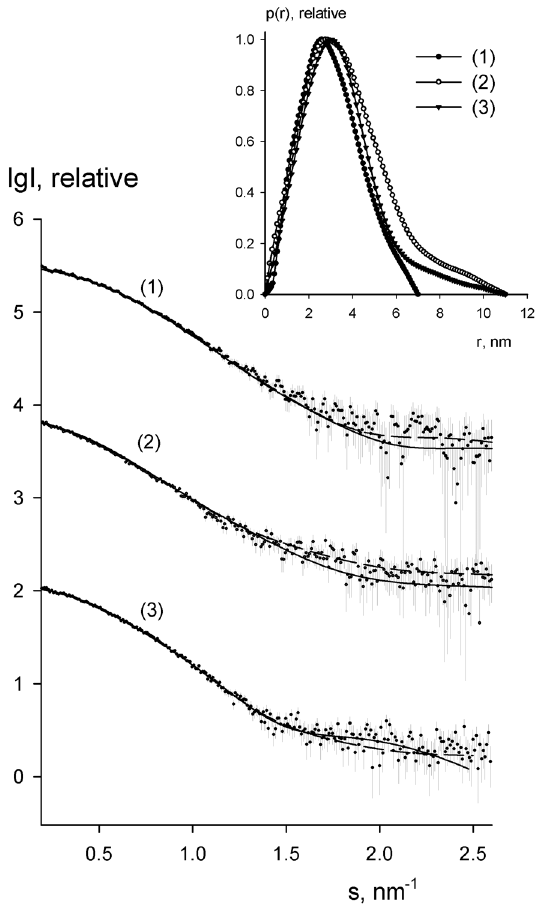
Figure 1. The experimental X-ray scattering data and the obtained fits. Curves 1–3 correspond to M.NlaX, M.SsoII and M.SsoII– 15met complex,respectively. Experimental data are displayed as dots with error bars, the scattering from the typical ab initio models computed by DAMMIN or MONSA as full lines, and the calculated fits by CRYSOL (M.NlaX) or EOM (M.SsoII and the complex) as dashed lines. The plots display the logarithm of the scattering intensity as a function of momentum transfer. The distance distribution functions are presented in the insert.